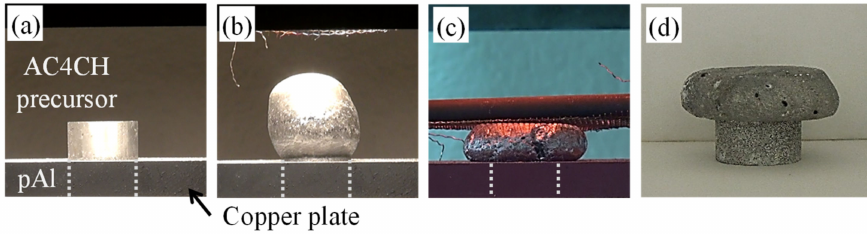
Figure 5. Foaming and press forming behavior of AC4CH/pAl sample when using flat die. ( a ) Before foaming. ( b ) Foamed. ( c ) Press formed. ( d ) Flattened AC4CH layer sample.